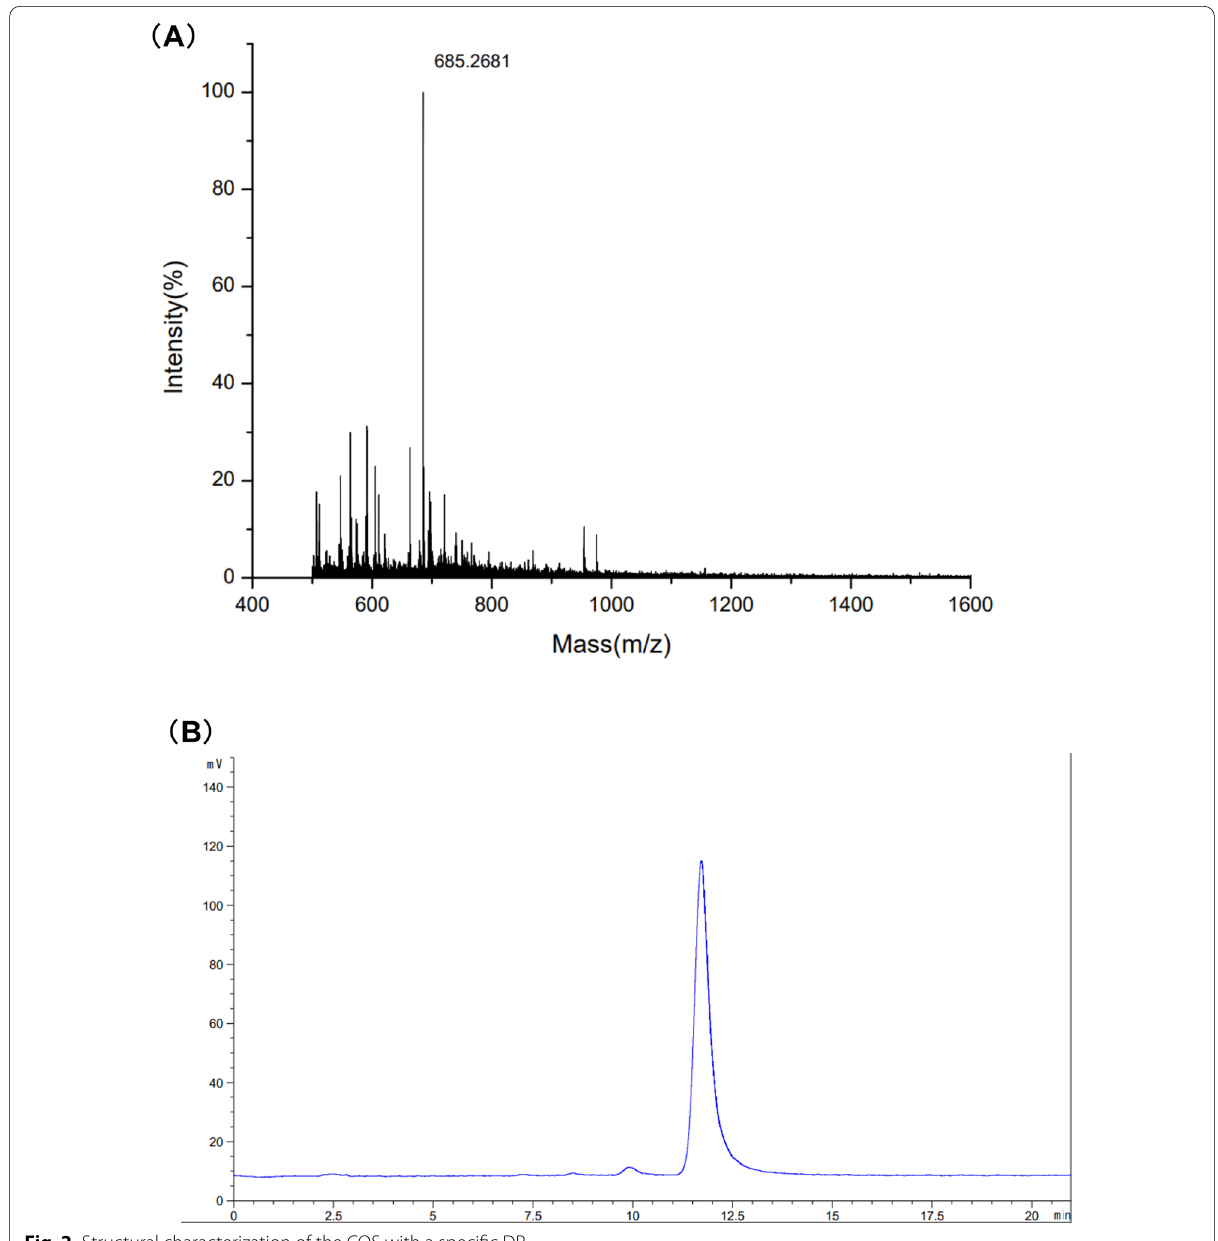
Fig. 2 Structural characterization of the COS with a specific